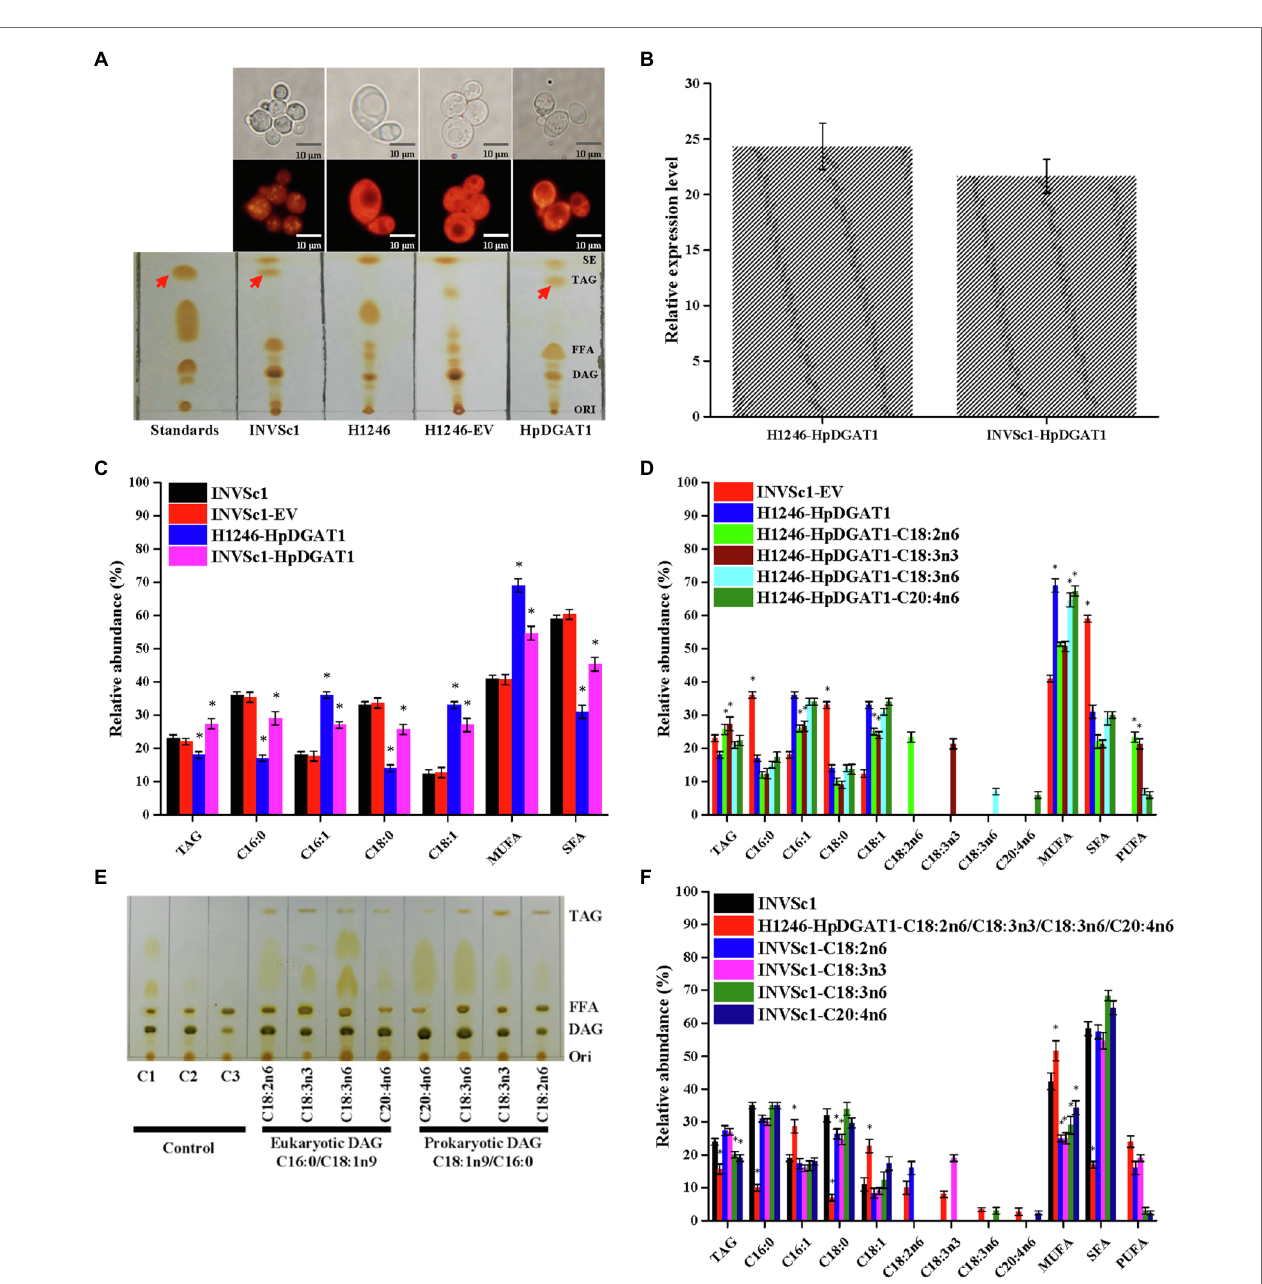
incorporated into TAGs in the HpDGAT1 -transgenic H1246 cells when fed with C18:3n3 or C18:2n6, respectively ( Figure 2D ), which were at the cost of lower levels of MUFAs (C16:1 and C18:1) and SFAs (C16:0 and C18:0). Conversely, the FA profiles in the HpDGAT1 -transgenic